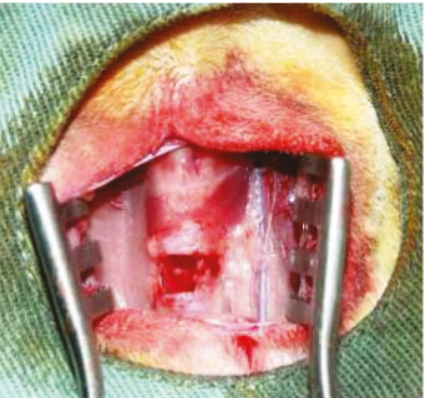
Figure 2: Trachea exposition with a 6 × 8 mm (48mm 2 ) defect made with a